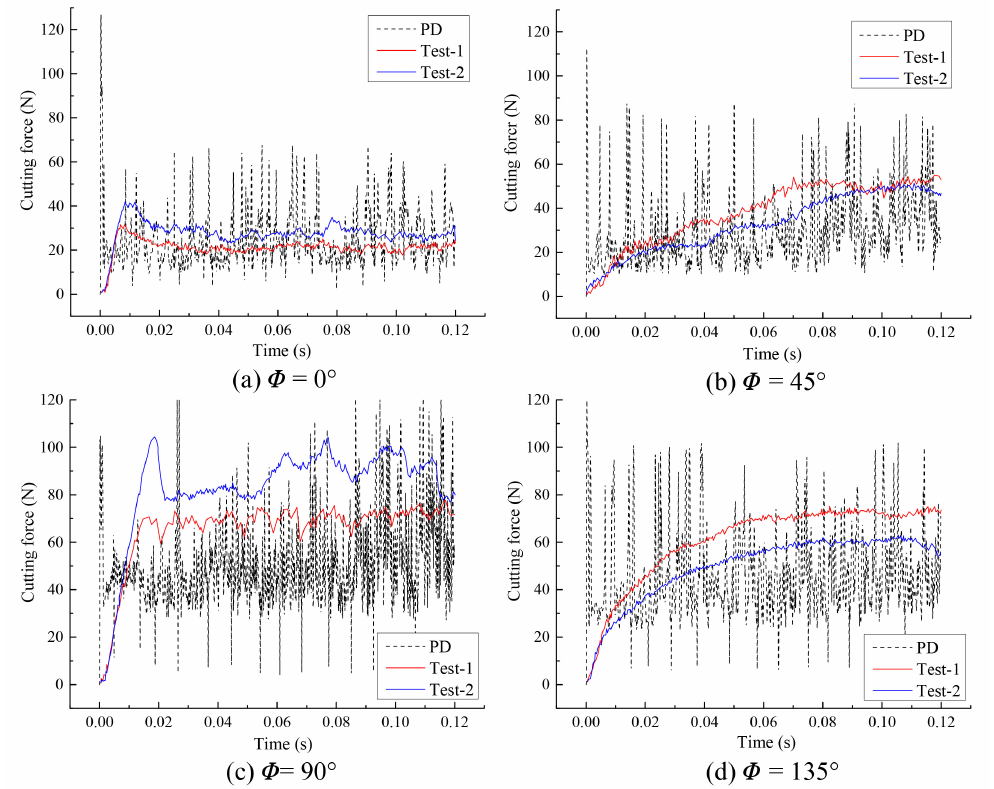
Figure 11. Comparison of simulation and experiment cutting force for different fiber orientations.